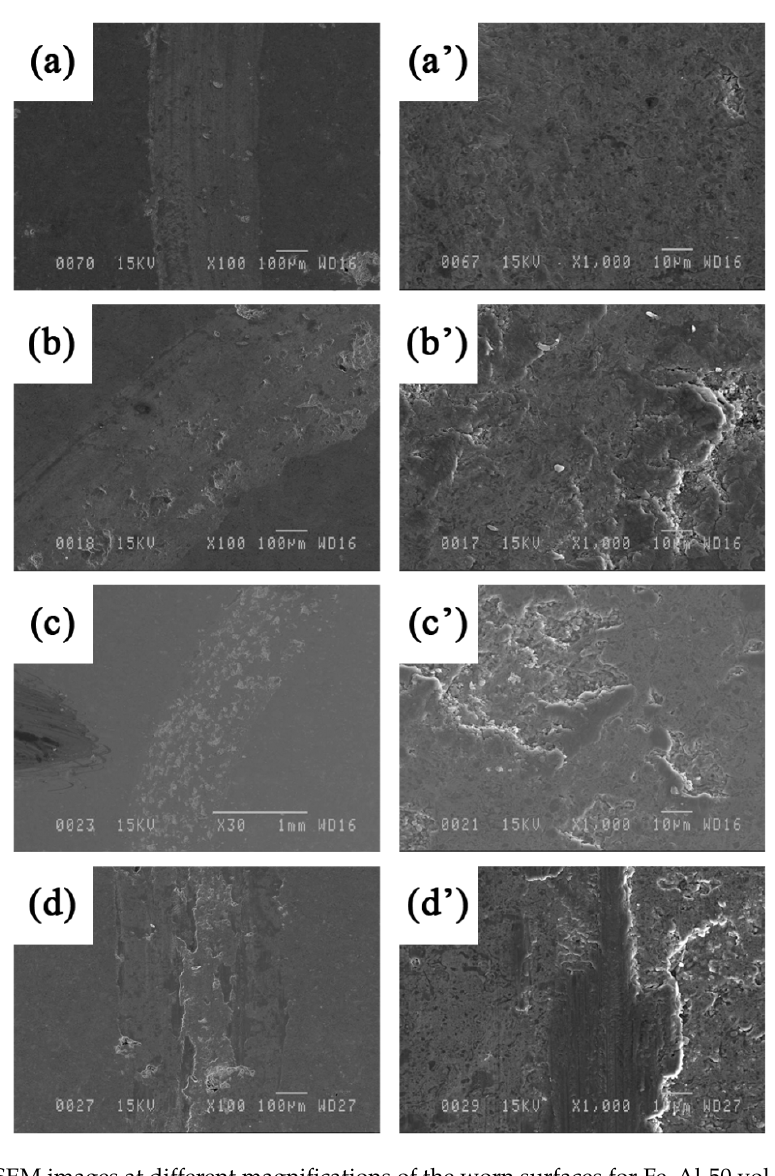
Figure 13. SEM images at different magnifications of the worn surfaces for Fe 3 Al ‐ 50 vol.% TiB 2 at a sliding speed of ( a and a’ ) 0.04, ( b and b’ ) 0.1, ( c and c’ ) 0.3 and ( d and d’ ) 0.8 m s − 1 under a load of 5 N.